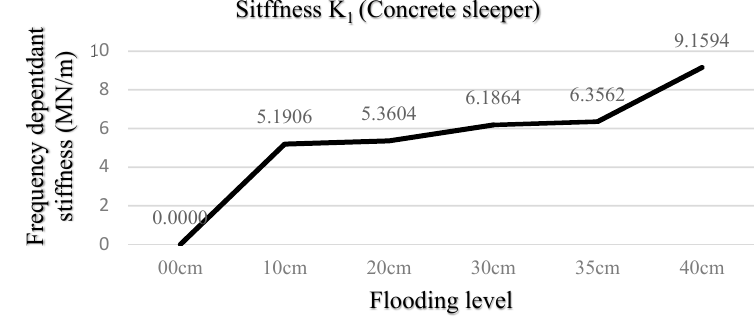
Figure 21. ( a ) comparison of dynamic damping at two models; ( b ) comparison of dynamic stiffness at two models.